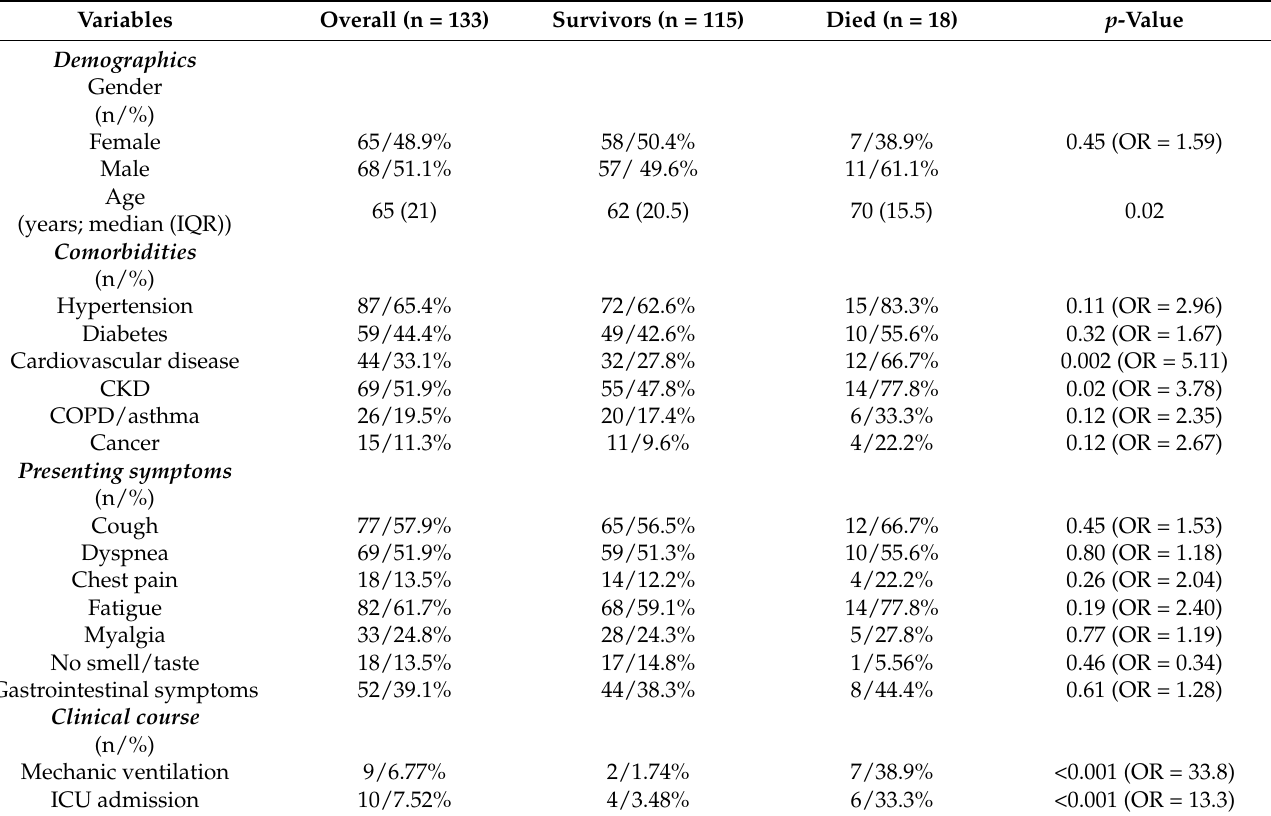
Table 1. Baseline characteristics of 133 COVID-19